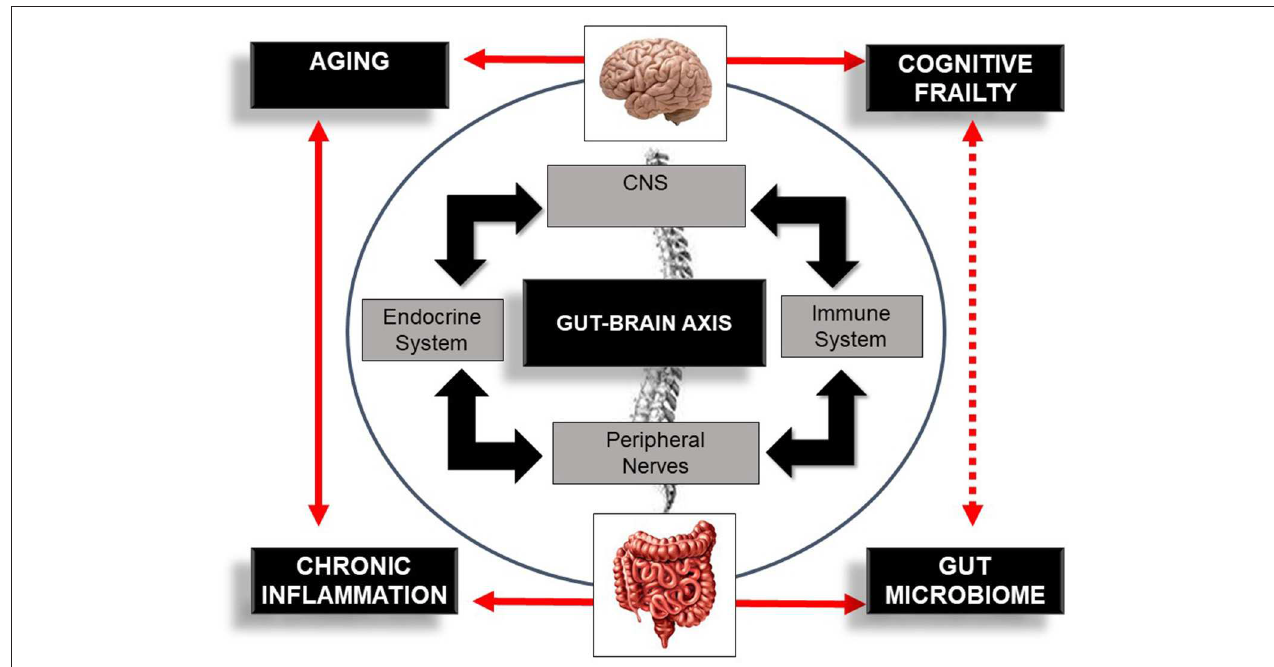
FIGURE 2 | Schematic illustration of the bi-directional communication system—the gut–brain axis—comprising the central nervous system (CNS), immune system, endocrine system, and peripheral nerves. The figure also illustrates the bi-directional influence of aging, inflammation, and the gut microbiome in cognitive frailty. Bold lines indicate an established association between concepts. Dotted lines indicate a potential association between this bi-directional network, the gut microbiome, and cognitive frailty. suppressors of cytokine signaling 3, and TLR4, the receptor for the microbial endotoxin lipopolysaccharide (LPS)